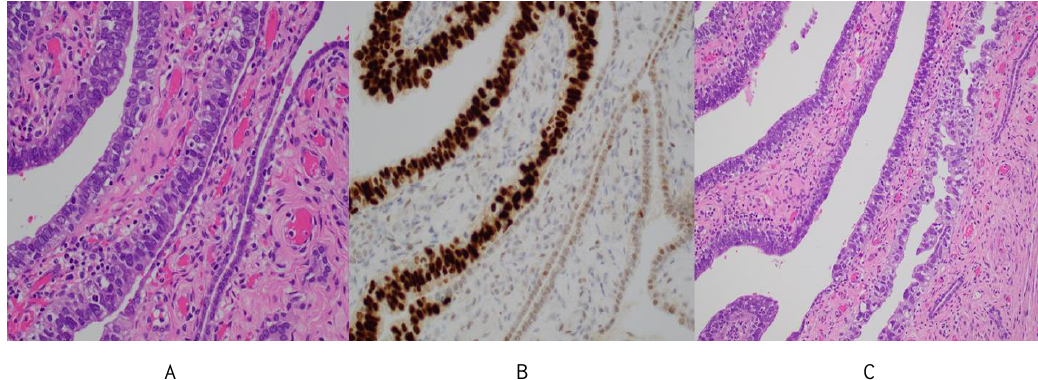
Figure 1. ( A ) Serous tubal intraepithelial carcinoma (STIC) (left) versus uninvolved fallopian tube (right). The STIC demonstrates loss of polarity with an increase in nuclear size with nuclear crowding and molding. ( B ) p53 immunohistochemistry highlighting strong and diffuse expression in STIC (left) versus uninvolved fallopian tube (right). ( C ) Lower magnification highlighting the hyperchromasia and marked nuclear pleomorphism associated with STIC.